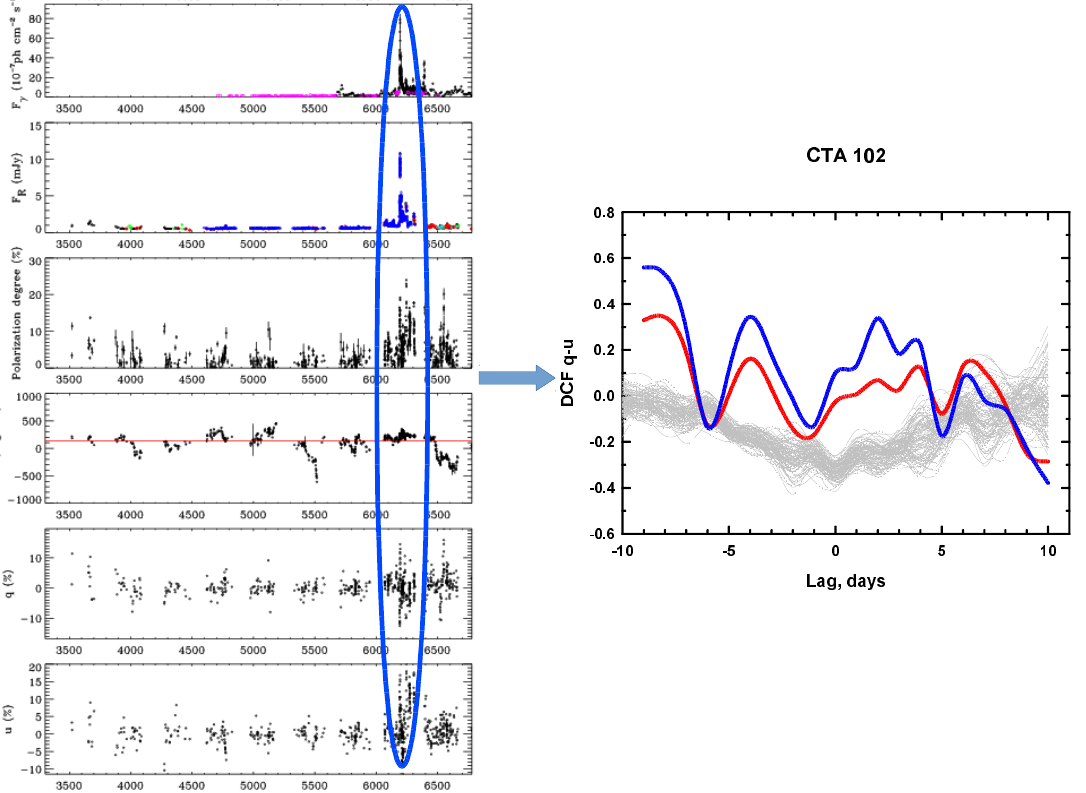
Figure 6. Left , from top to bottom: Fermi γ -ray light curve of CTA 102, R band light curve, evolution of PD , evolution of EVPA , evolution of Stokes parameters. Blue oval singles out the huge outburst of 2012. Right : blue line—DCF between q and u for the time interval of outburst, red line—for the whole data set, gray stripe is created by 100 Monte Carlo simulations assuming an absence of regular